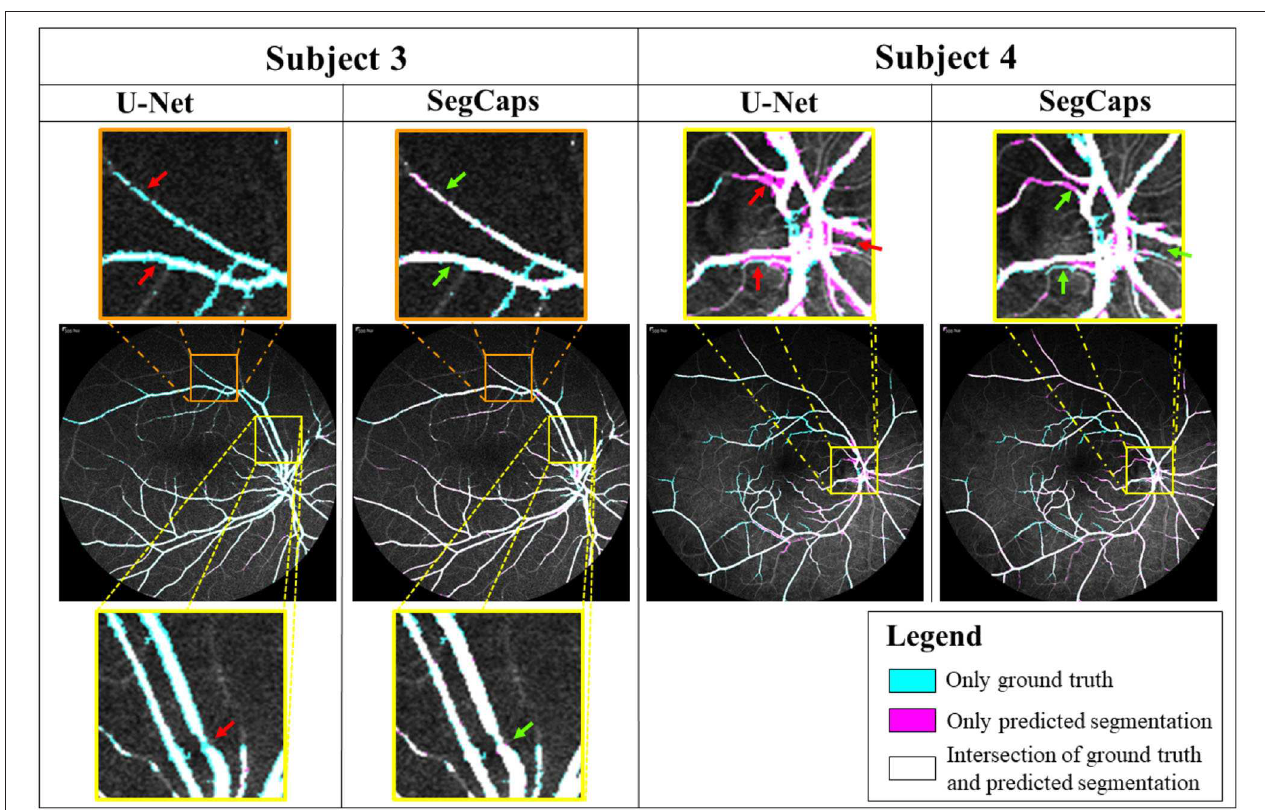
FIGURE 12 | Comparison of segmentation results on U-Net and baseline SegCaps . Despite achieving similar quantitative results, we can see SegCaps outperforms U-Net in challenging regions as denoted by the corresponding red ( U-Net ) and green ( SegCaps ) arrows. U-Net struggles with under-segmentations in Subject 3 and over-segmentations in Subject 4.